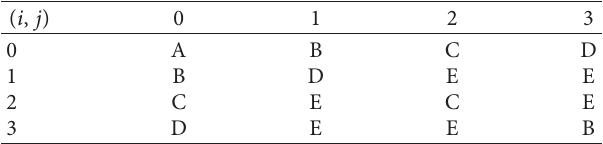
Table 2: p ≡ q ( mod8 )